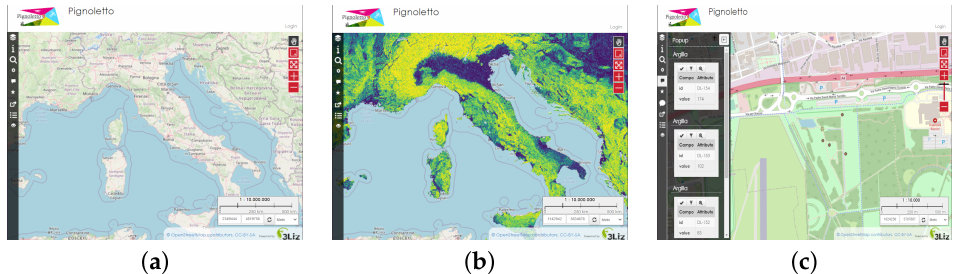
Figure 3. Main functionalities of the platform: ( a ) Initial view; ( b ) Raster layer selected; ( c ) Zoom on